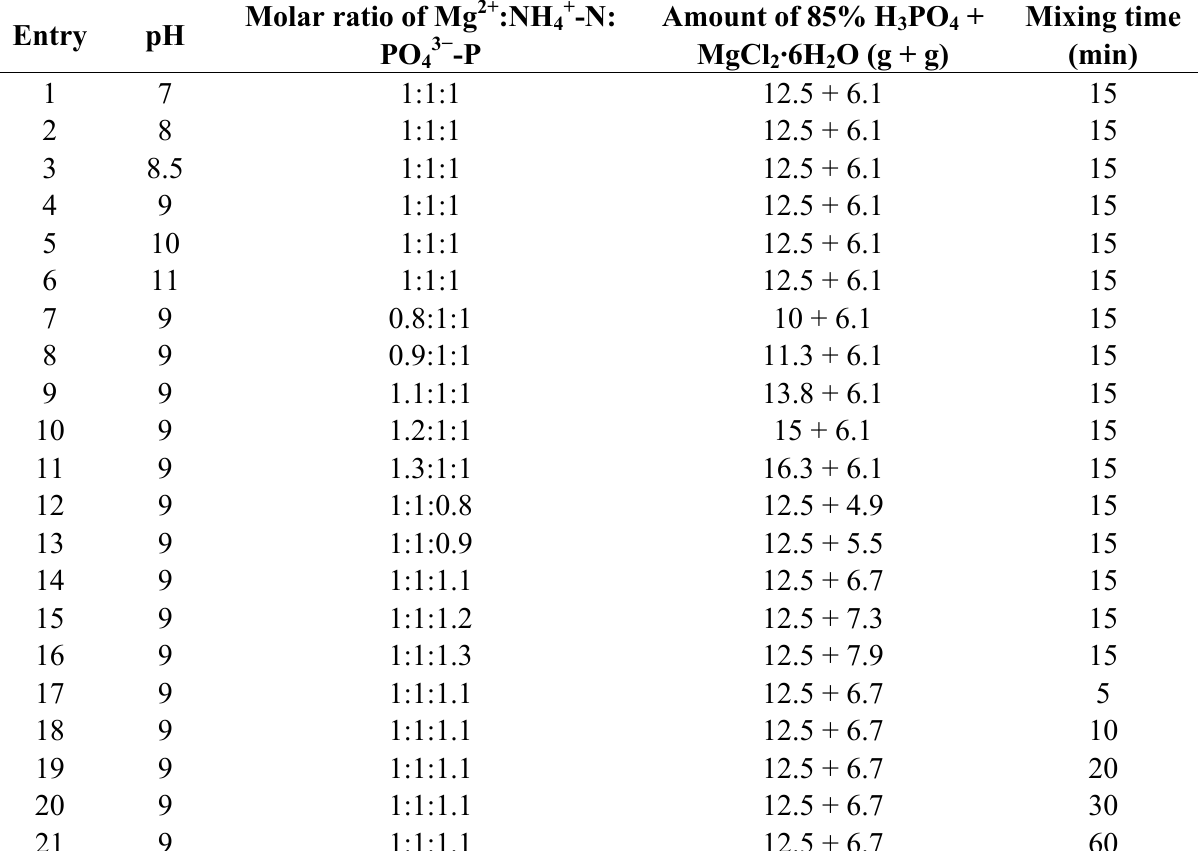
Table 3. Experimental conditions of struvite precipitation for the removal of NH 4+ -N (initial NH 4+ -N concentration of 1,128